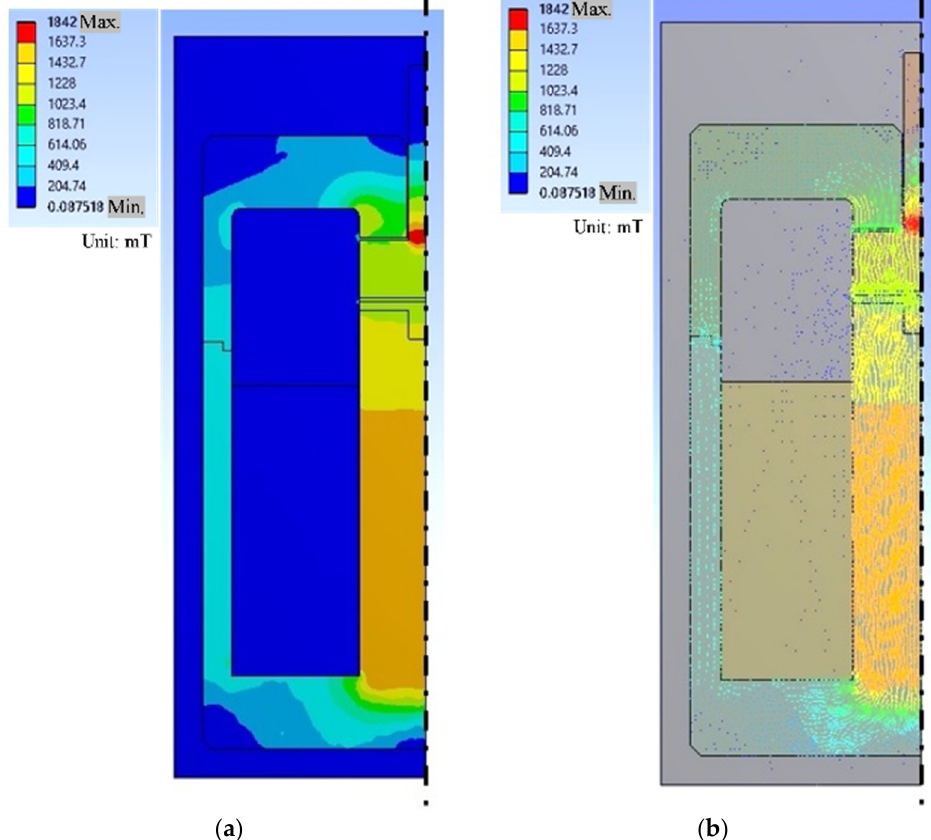
Figure 7. Distribution of magnetic field in the parallel plate setting (full view). ( a ) Contour, ( b ) vec- tor.